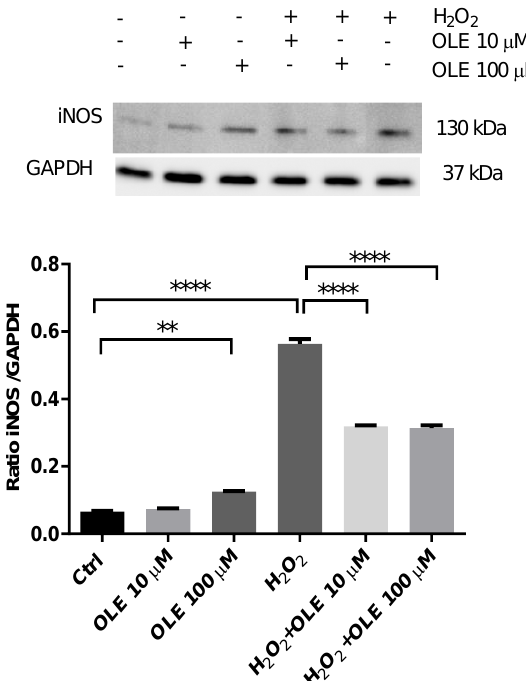
Figure 6. The effect of oleuropein (OLE) on the inducible nitric oxide synthase (iNOS) protein expression in H 2 O 2 -exposed HTR-8/SVneo cells. Upper panel, representative Western blot of iNOS; lower panel, densitometric analysis of iNOS expression in HTR-8/SVneo cells. The data are expressed as mean + SEM. ** p < 0.01, **** p < 0.0001.